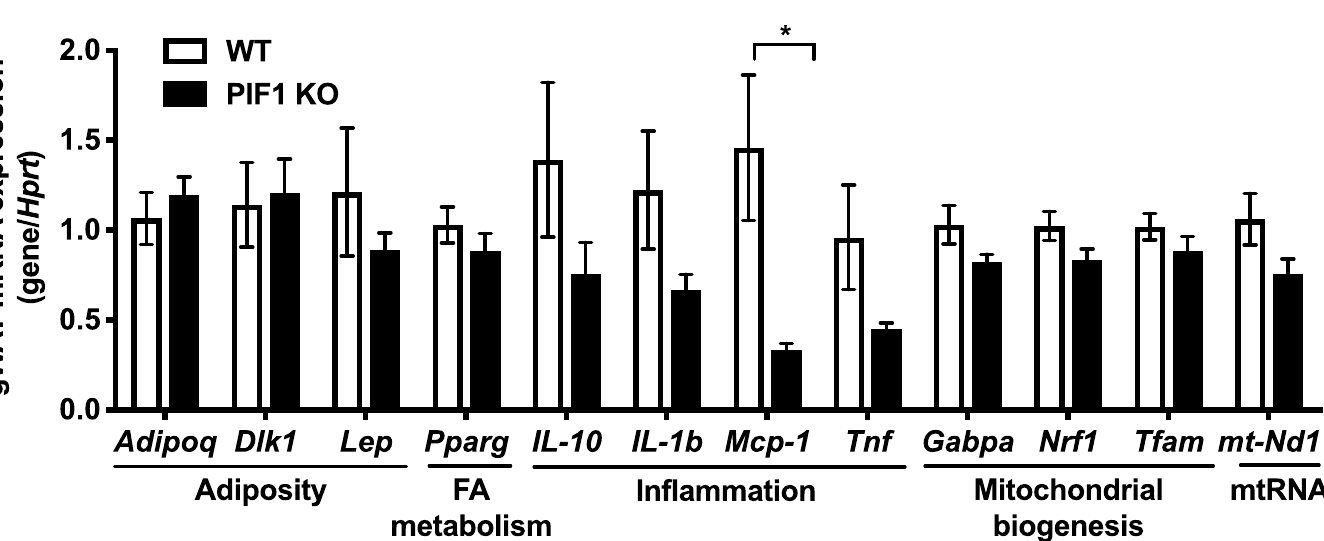
Fig 6. Transcript levels for inflammatory markers were decreased in adipose tissue from Western diet (WD)-fed PIF1 KO females. Gonadal white adipose tissue (gWAT) cDNA from WD-fed, WT and PIF1 KO mice was used to measure transcripts for genes involved in adiposity, fatty acid (FA) metabolism, inflammation, mitochondrial biogenesis and mitochondrial RNA. mRNA expression relative to the hypoxanthine-guanine phosphoribosyltransferase ( Hprt ) reference gene. All data are mean ± SEM; n = 8–12 mice per group; pvalues determined by Student’s T-test, � p < 0.05.